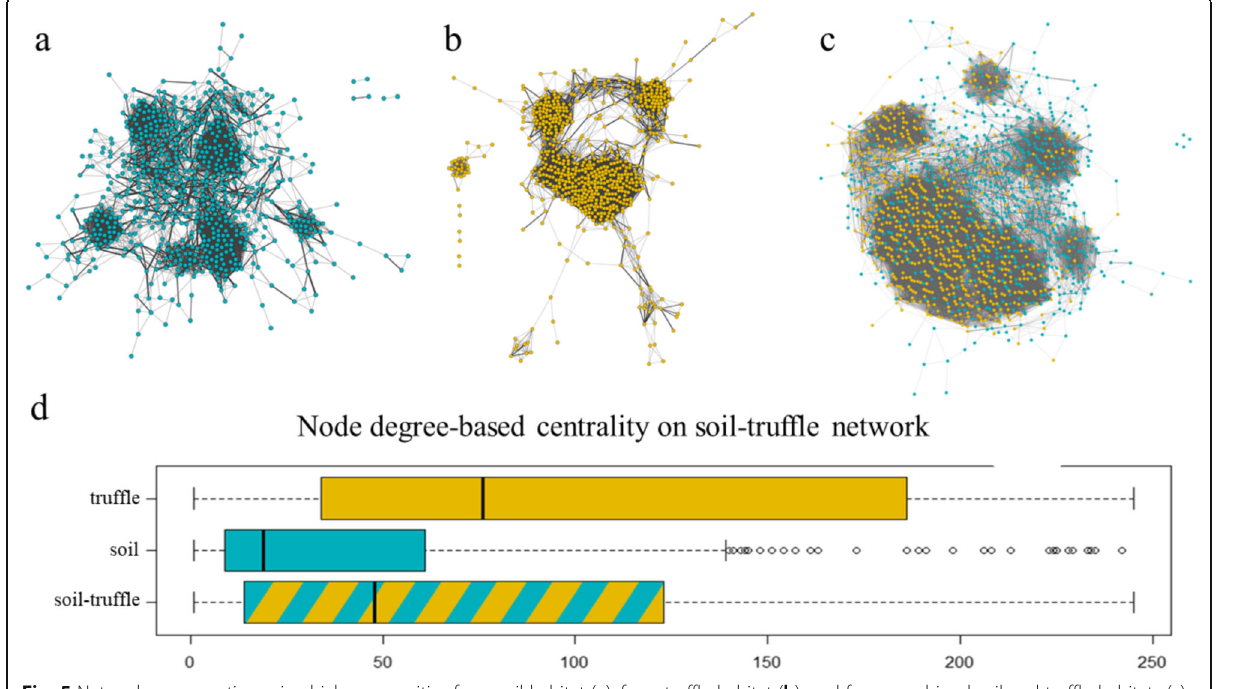
Fig. 5 Networks representing microbial communities from soil habitat ( a ), from truffle habitat ( b ), and from combined soil and truffle habitats ( c ). Each node represents a species, and node color is related to the habitat the species belongs to (blue for soil habitat and yellow for truffle one). Edges (lines) between nodes represent a significant correlation between the abundances of the species connected by. Edge width is proportional to the significance of correlation between species. Networks are plotted by organic layout in Cytoscape. d Species identified in the truffle habitat have a higher connectivity (measured by node degree centrality) than species identified in the soil habitat (respectively yellow and blue boxplots). The network derived from abundances combined from species identified in soil and truffle habitats has a connectivity lower respect the only truffle component and higher respect the only soil component (striped